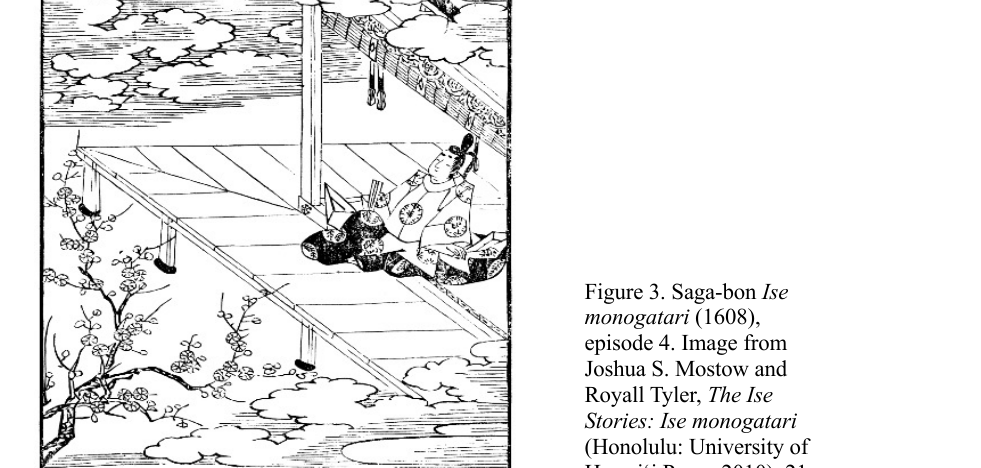
Figure 3. Saga-bon Ise monogatari (1608), episode 4. Image from Joshua S. Mostow and Stories: Ise monogatari (Honolulu: University of Hawai‘i Press, 2010),